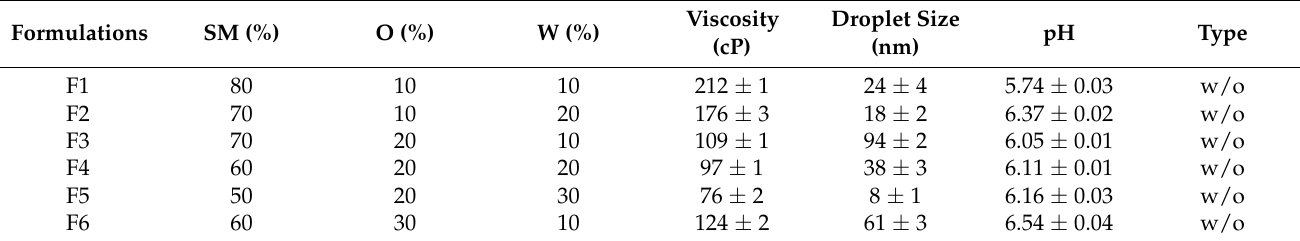
Table 4. Physical properties of the transparent microemulsion in the M6 diagram.